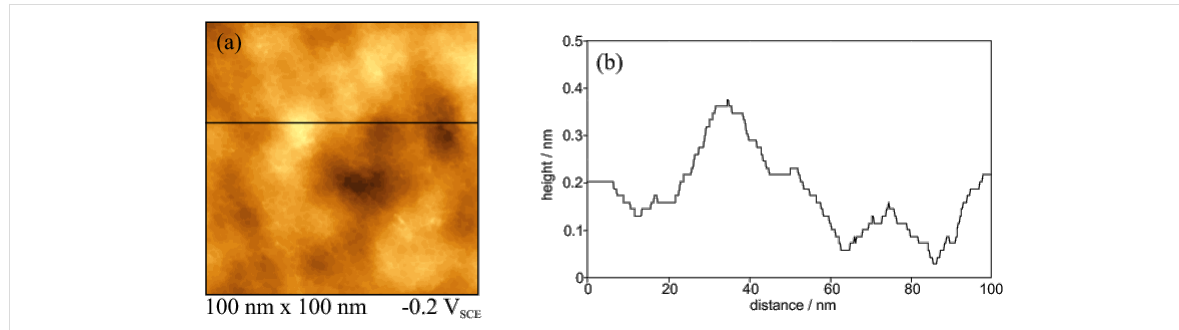
Figure 2: (a) in situ STM image of CO-cooled Ir(210) in 0.1 M H 2 SO 4 at − 0.2 V. (b) Height profile along the line shown in (a).